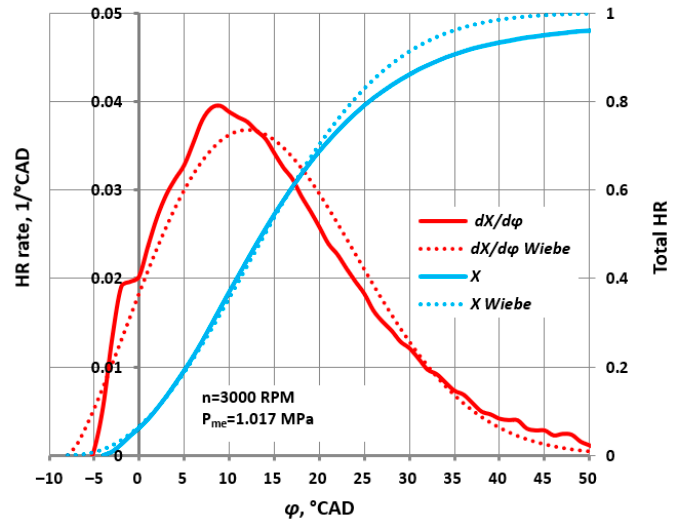
Figure 2. The characteristics (real and calculated by Wiebe function) of heat release and total fuel combustion of 1.9 TDI 1Z engine running on diesel fuel ( n = 3000 min − 1 and P me = 1.0712 MPa).